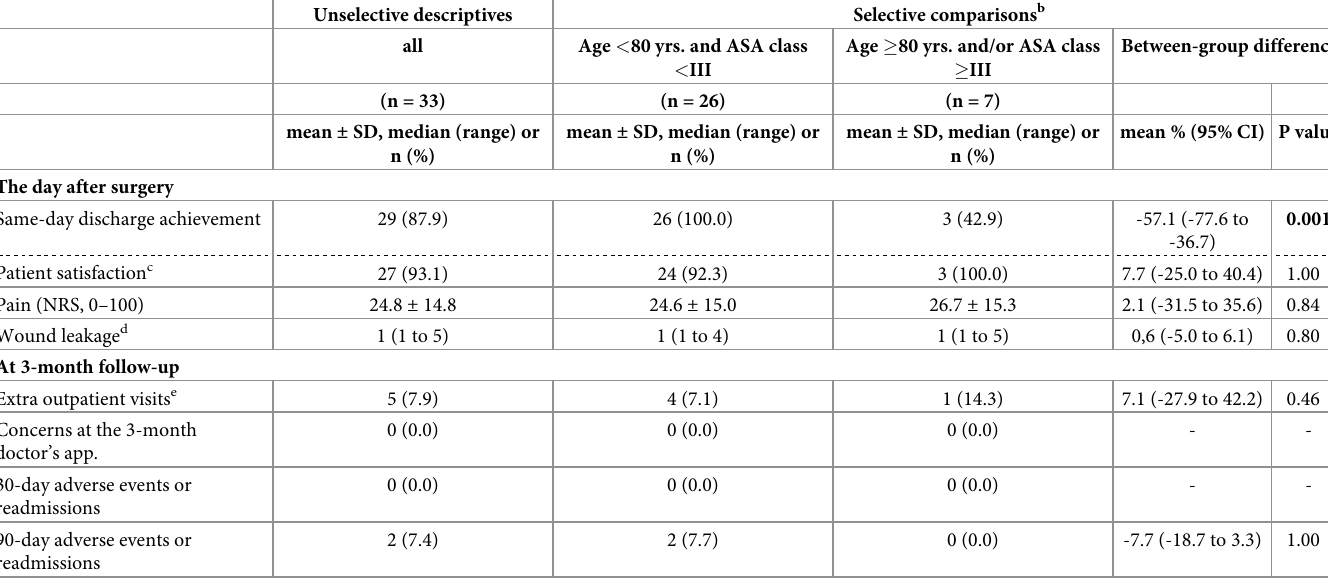
Table 2. Descriptives and unadjusted subgroup analyses a of postoperative efficacy, patient satisfaction, and safety outcome